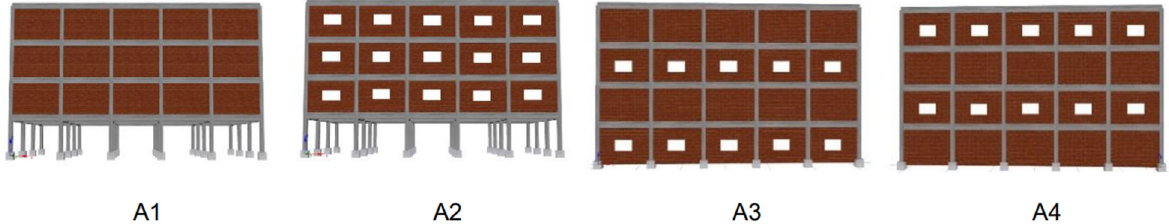
Figure 10. Models under study in Scenario A.